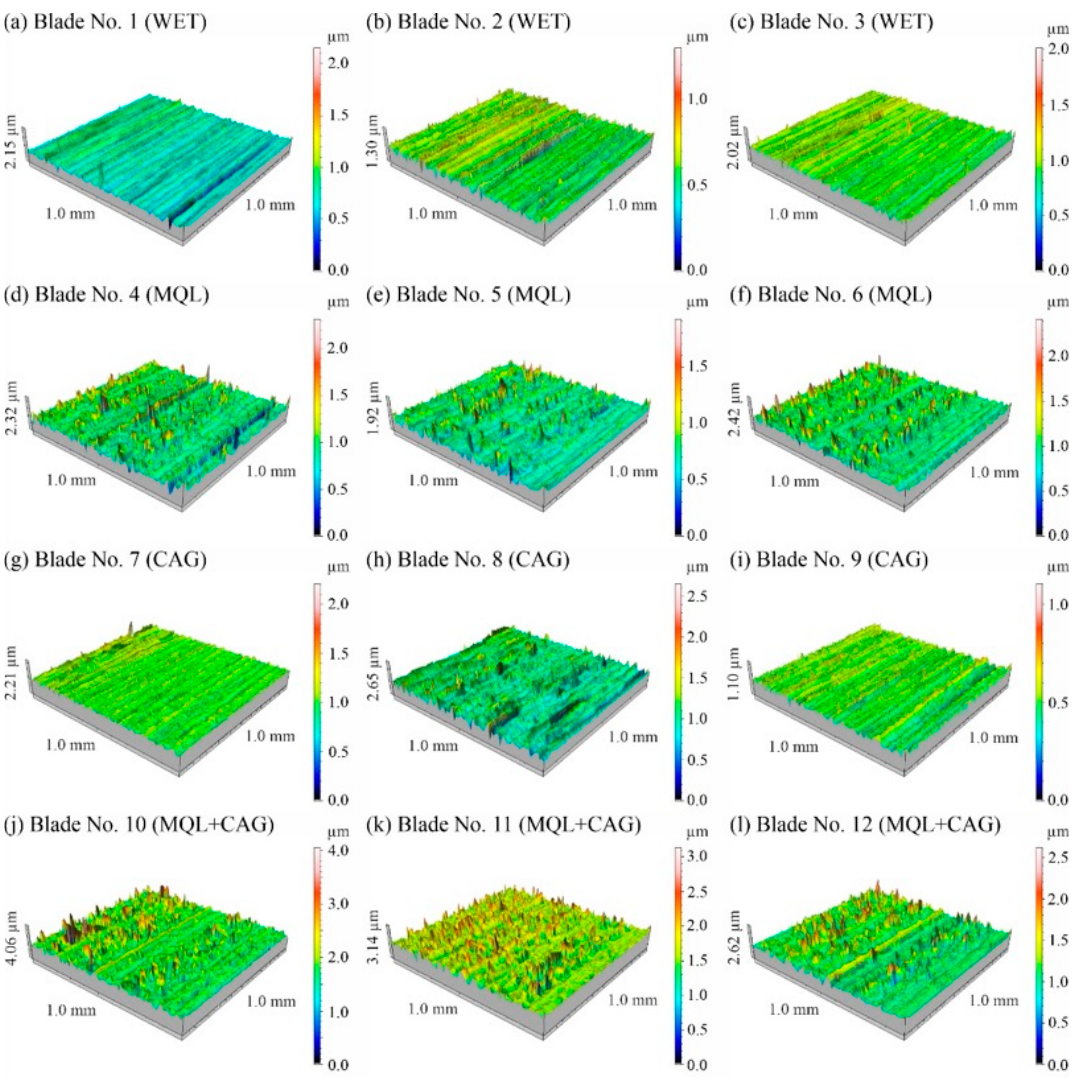
Figure 6. View of surface microtopography (1.0 × 1.0 mm) of planar knives measured on a test stand